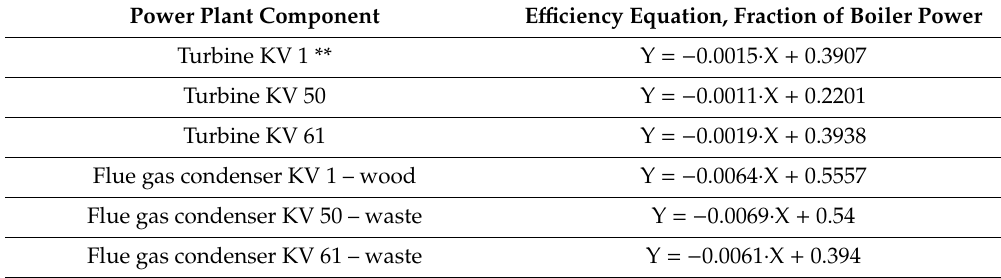
Table 6. Temperature-dependent e ffi ciencies in the MODEST model (Y = e ffi ciency as fraction of boiler power; X = temperature [ ◦ C]).